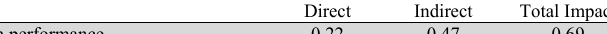
The indirect effect exists at significance level of